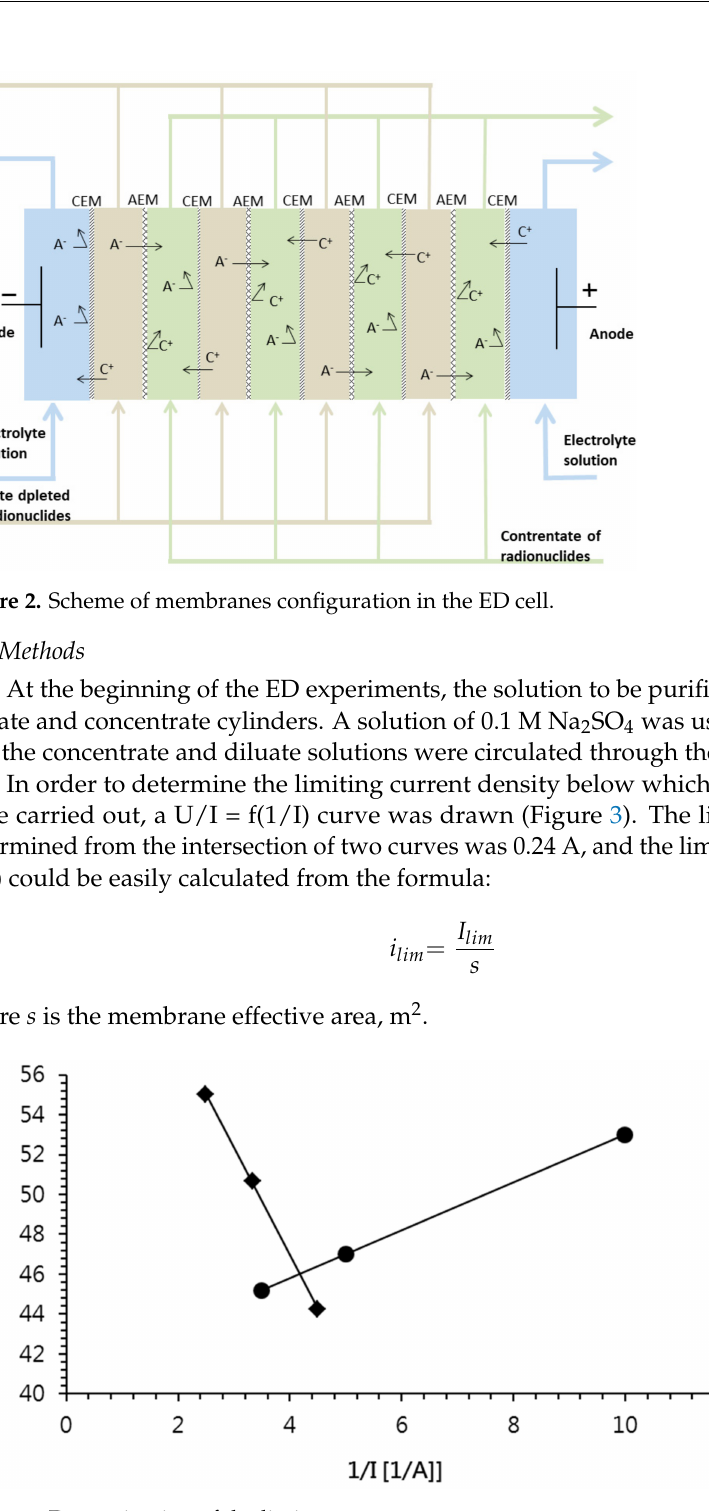
Figure 3. Determination of the limit